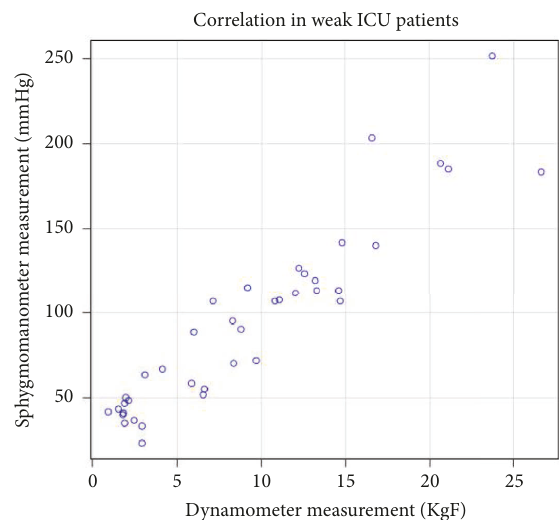
Figure 2: Correlation between grip strength techniques in pre- admission surgical patients.